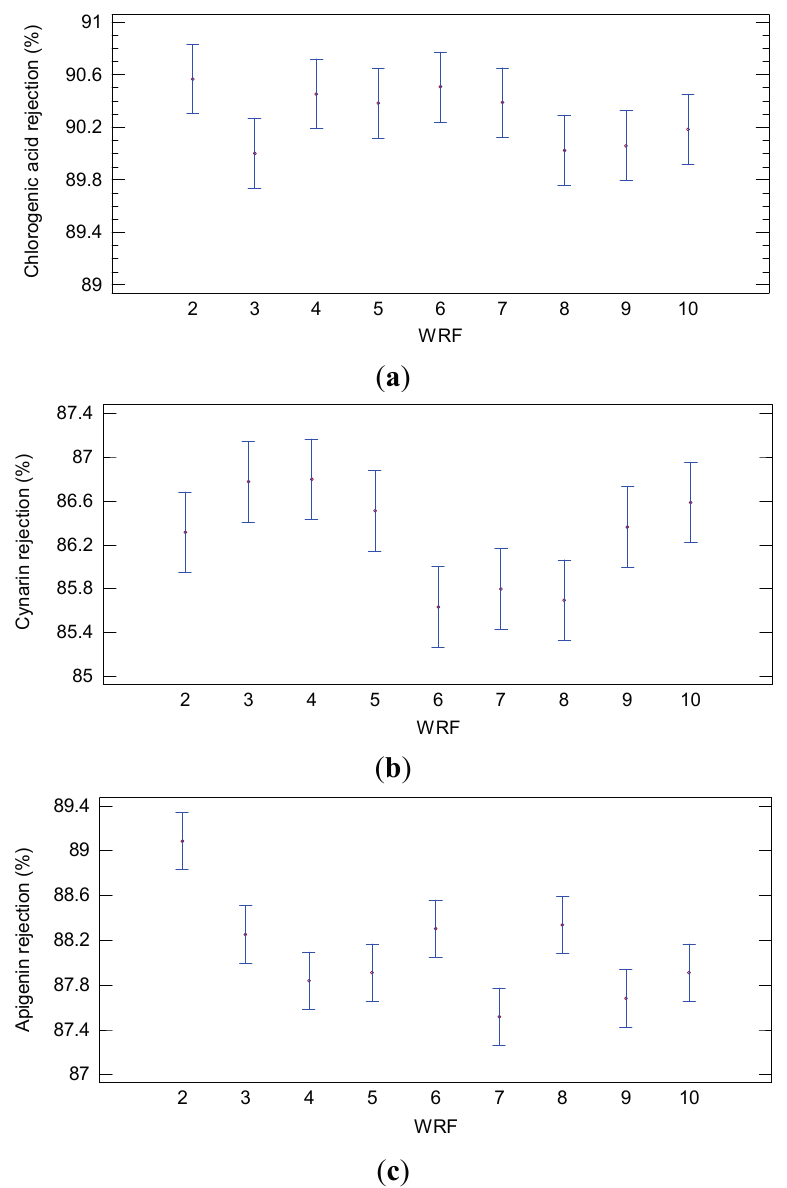
Figure 6. Least significant difference (LSD) plot showing the effect of WRF on the rejection of ( a ) chlorogenic acid ( b ) cynarin and ( c ) apigenin (NP030 membrane, batch concentration configuration, 4 bar, 25